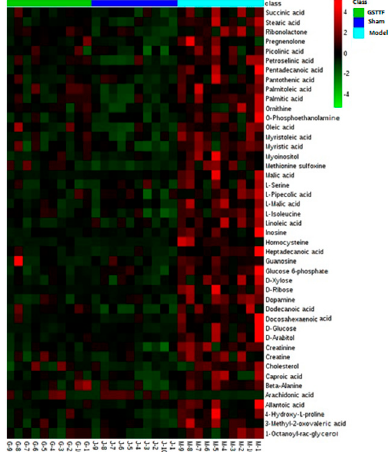
Figure 4. Heat map visualizing the changes in the contents of potential biomarkers. Rows: biomarkers; Columns: samples. Color key indicates the concentration of metabolites, green: lowest, red: highest.